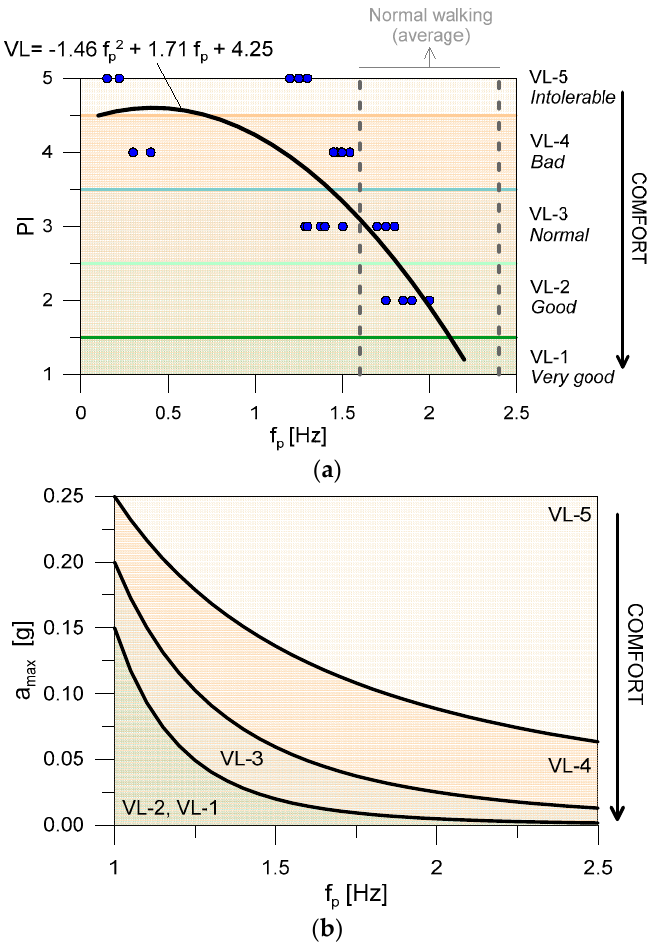
Figure 15. Analytical correlation between ( a ) experimental walking frequencies f p and corresponding vibration comfort levels VL (vertical direction) for the examined system, and ( b ) definition of possible perception curves for graphical comfort assessment.